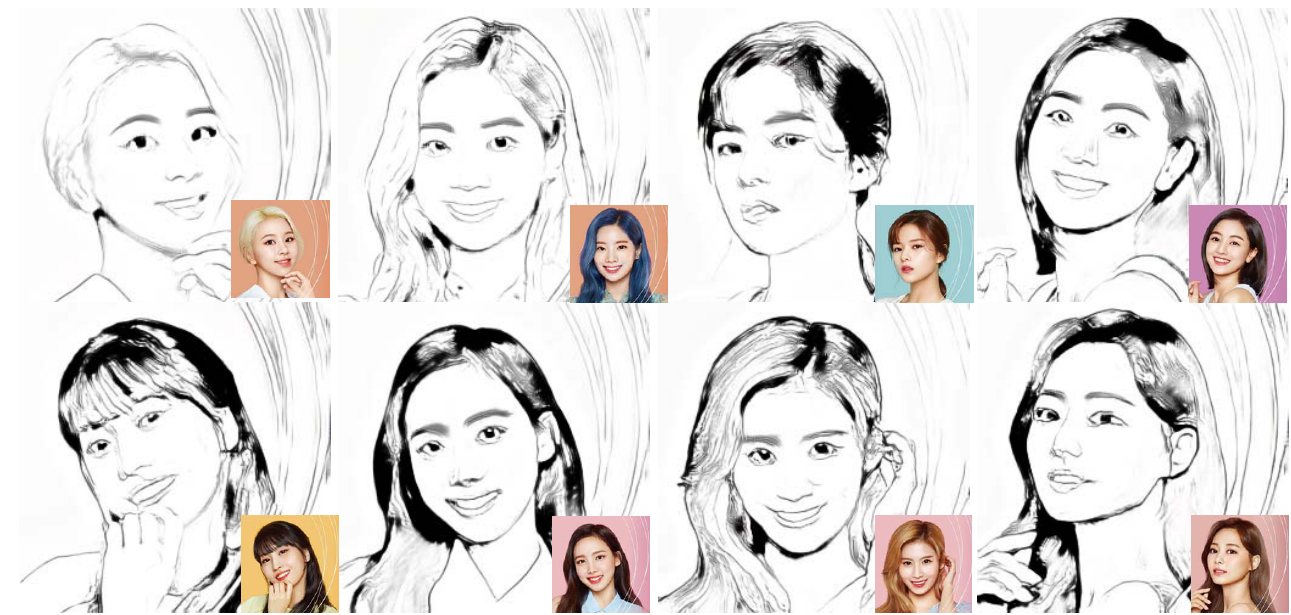
Figure 1. The teaser images of our